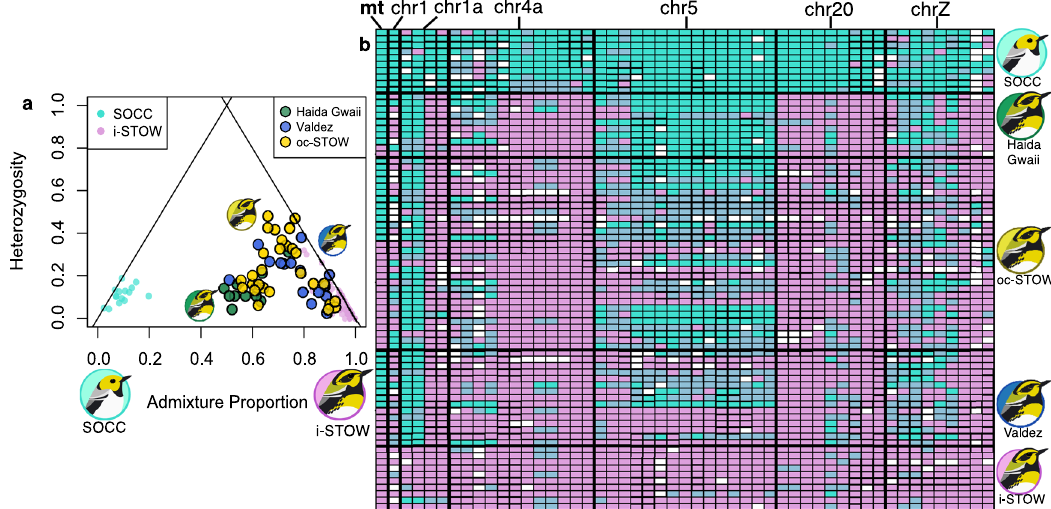
Fig. 2 The signature of admixture in coastal S. townsendi (coastal STOW) populations. a Triangle plot showing relationship between individual admixture proportion vs. heterozygosity based on 50 ancestry-informative SNPs ( F ST > 0.6) between S. occidentalis (SOCC) and inland S. townsendi (inland STOW), showing that coastal STOW populations (three genetic clusters in Fig. 1d, green: Haida Gwaii, blue: Valdez; army brown circling gold: oc-STOW) are admixtures between SOCC and inland STOW-like population. b Ancestry score (homozygotes SOCC and inland STOW, respectively, in turquoise and magenta, heterozygotes in light blue) of mtDNA and 50 ancestry-informative nDNA SNPs ( F ST > 0.6) in chr 1, 1a, 4a, 5, 20, and Z of randomly sampled 10 individuals from parental populations (SOCC and inland STOW), and different coastal STOW populations. Bird illustrations by Gil Jorge Barros